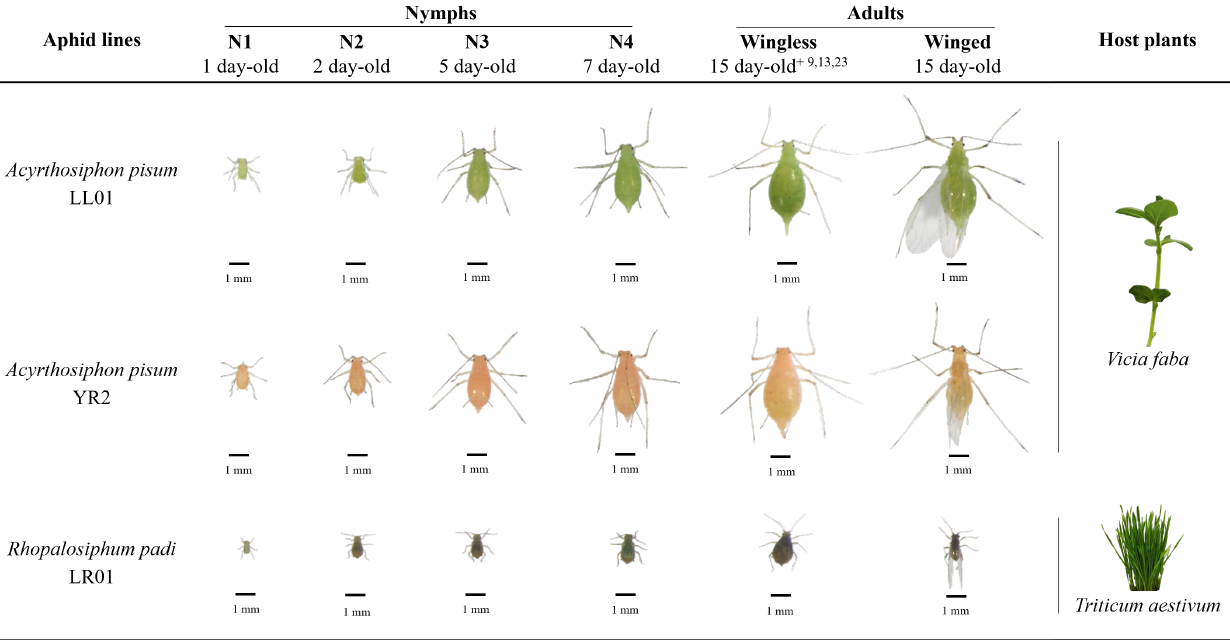
Figure 1. Developmental stages of the three aphid lines used in this work. These aphid lines have different colors and sizes. The database consists of images of living aphids from the three lines at nine developmental stages with three biological replicates under two different conditions (aphids on a neutral background or their host plant leaf), providing over 160 hyperspectral images. Adapted from Gaetani et al. [43].